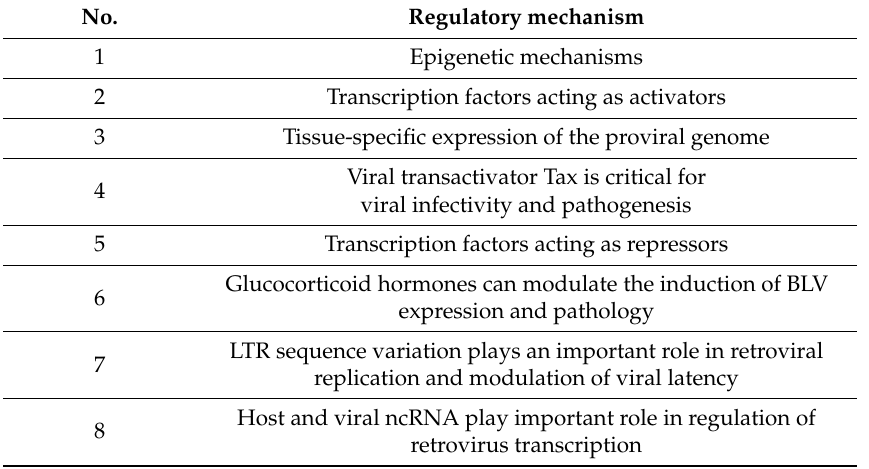
Table2. Summaryofmechanismsunderlyingtranscriptionalregulationandlatencyofdeltaretroviruses.